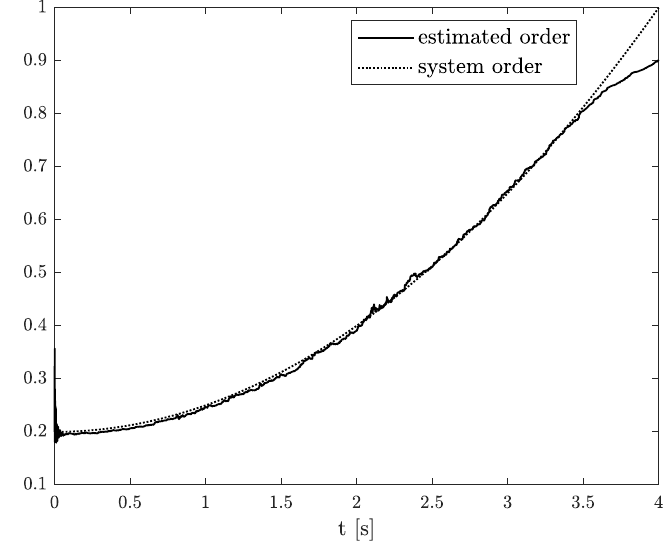
Figure 9. Original and estimated order from Example